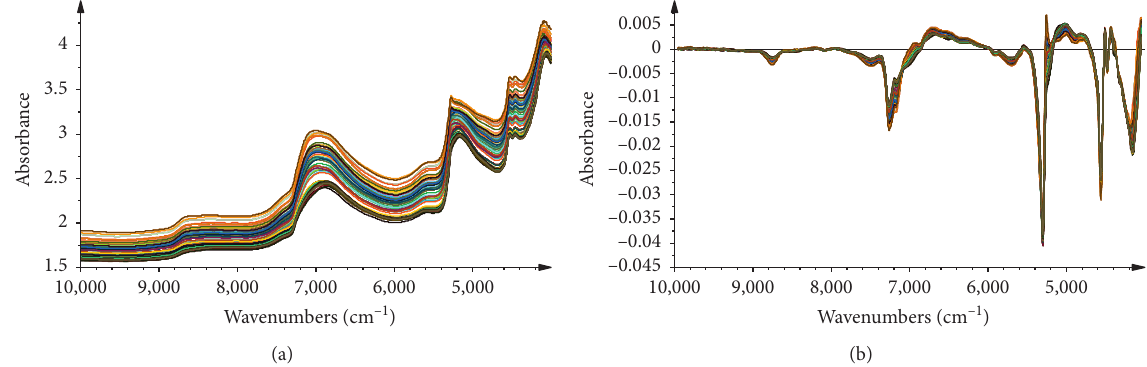
Figure 2: (a) Raw NIR spectra and (b) spectra preprocessed by MSC +FD/SG of all samples collected from the steaming